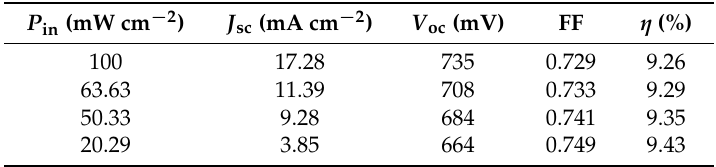
Table 2. Detailed photovoltaic parameters of the DSSC based on the Sn-doped TiO 2 NWAs (TS2) with a light scattering layer under different incident light intensities.